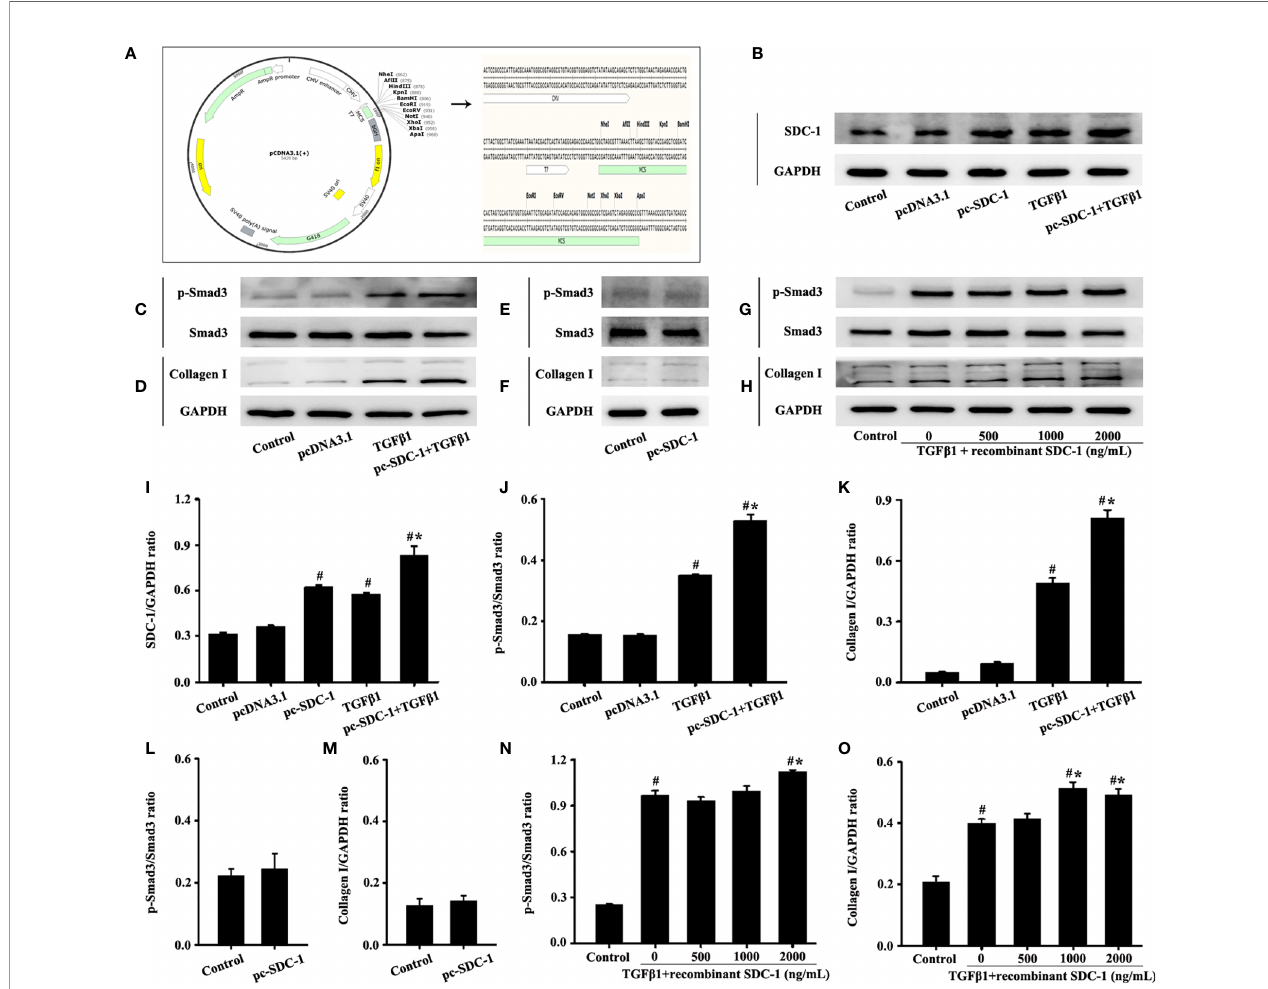
FIGURE 5 | Effects of SDC-1 overexpression by pc-SDC-1 or addition of the recombinant human SDC-1 protein on the levels of collagen I and p-Smad3 in Beas- 2B cells were observed. Plasmid vector atlas of SDC-1 overexpression (A) . Effect of pc-SDC-1 overexpression on TGF b 1-stimulated SDC-1 expression (B) was detected by Western blot. Effect of SDC-1 overexpression on the levels of p-Smad3 (C, E) and collagen I (D, F) were detected. Effects of the addition of different concentrations of the recombinant human SDC-1 protein on TGF b 1-stimulated p-Smad3 (G) and collagen I (H) were detected by Western blot. (I – O) Protein intensity analysis of (B – H) , respectively. Data are shown as the means ± SD of three independent experiments. # p < 0.05 versus the control group. # *p < 0.05 versus the TGF b 1